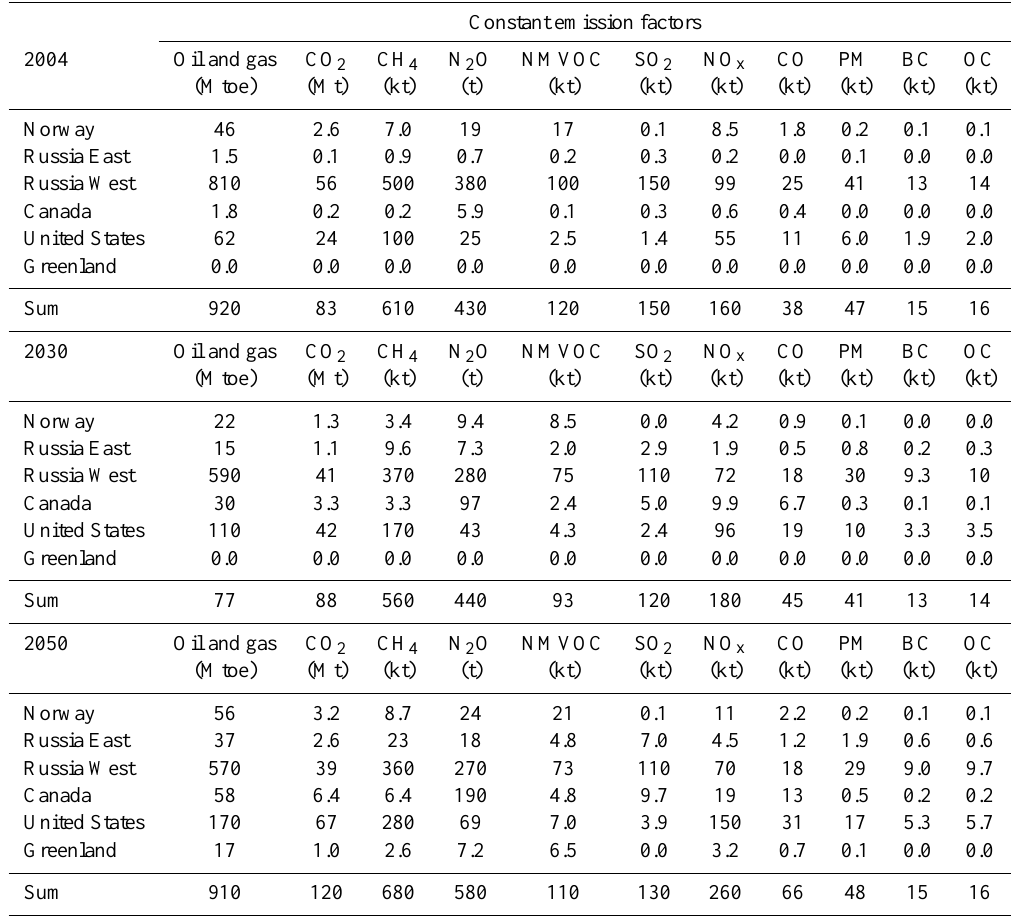
Table 2. Estimated emissions from oil and gas extraction in the Arctic assuming 2004 emission factors in each